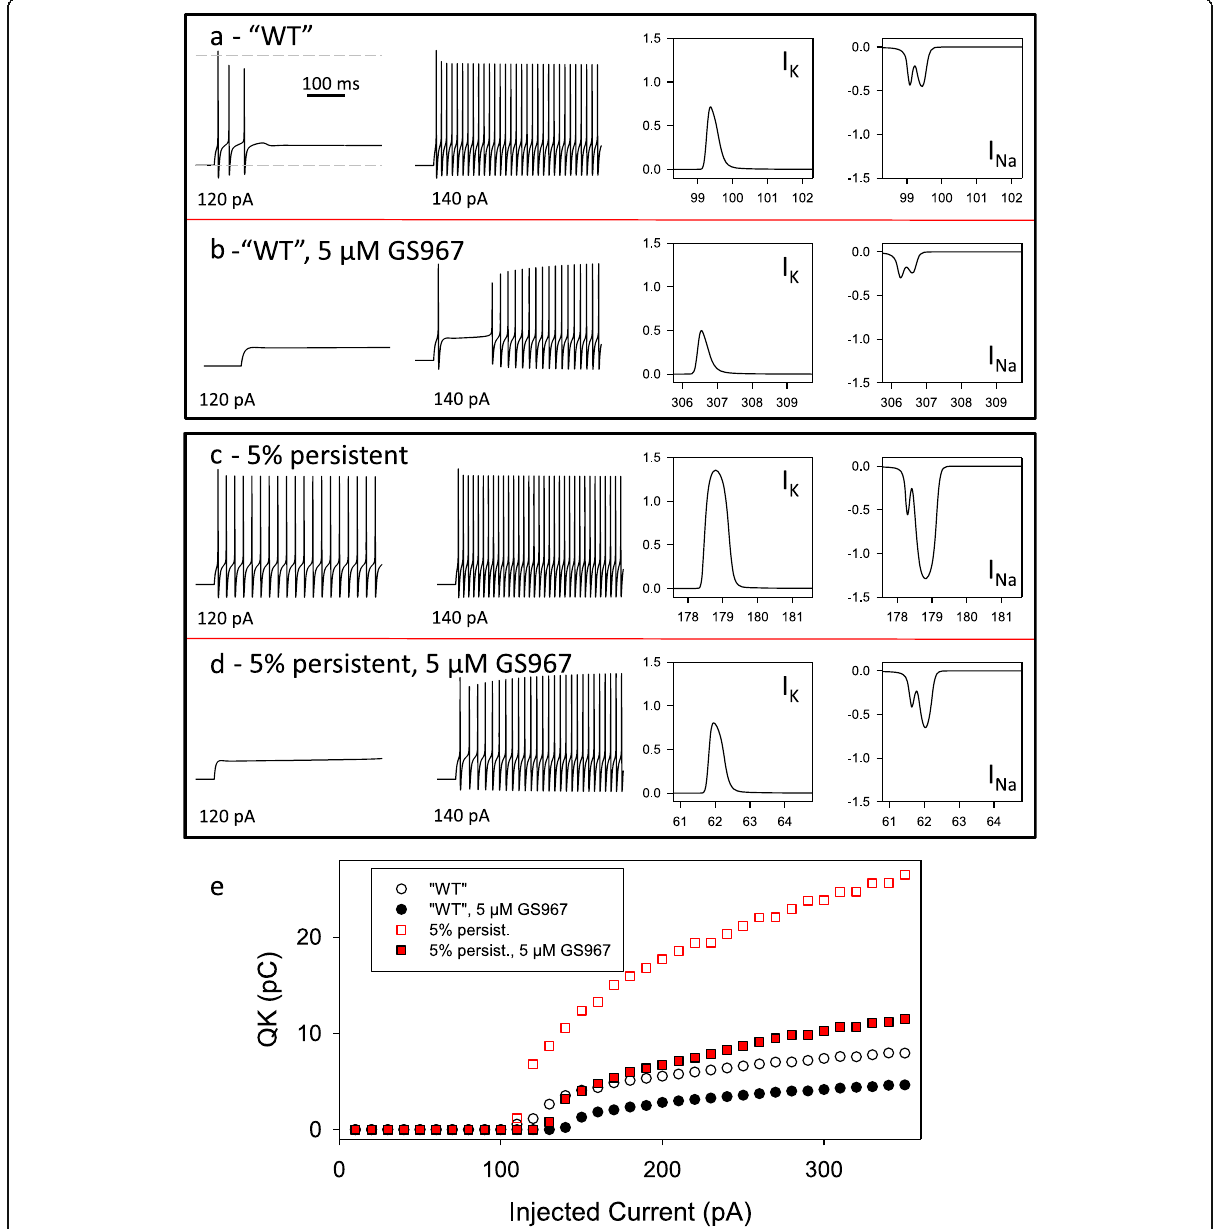
Fig. 6 Simulation of neuronal firing. A single compartment neuron was simulated with the program Neuron as described in methods, with a “ WT ” like Na + channel (without persistent currents) and with a Na + channels with 5% persistent currents, each in the absence and presence of GS967. Each pane ( a - d ) shows on the left the membrane potential as a function of time for current injections of 120 and 140 pA, and on the right the K + and Na + currents of a single action potential. In panel e the integrated K + efflux during the 400 ms stimulation period is shown as a function of the injected current for the indicated